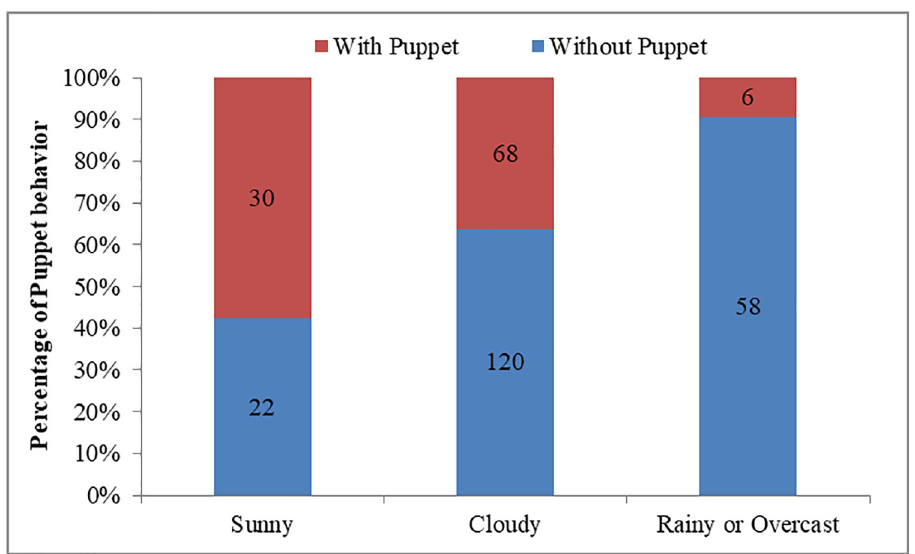
Fig 4. Effect of weather on the occurrence of Puppet behavior of Tibetan antelopes.